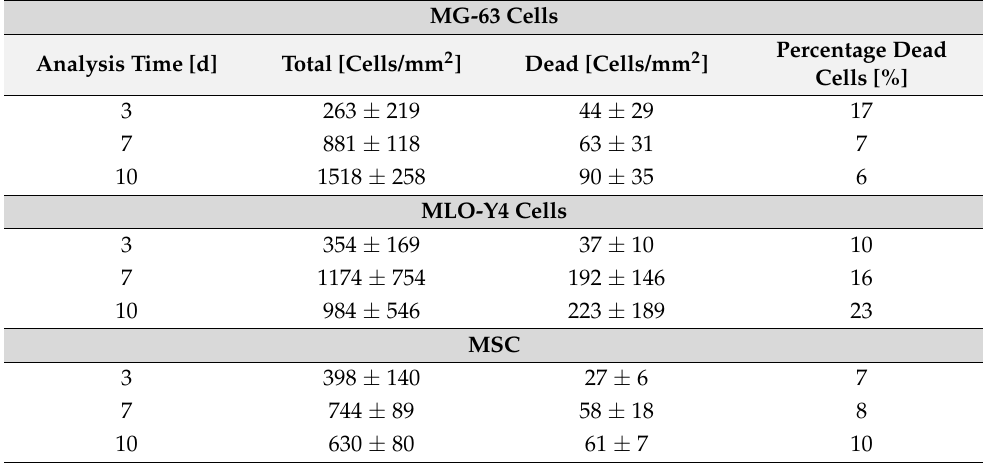
Table 3. Number of all cells or dead cells, and percentage of dead cells for three different cell lines (MG-63, MLO-Y4, MSC).